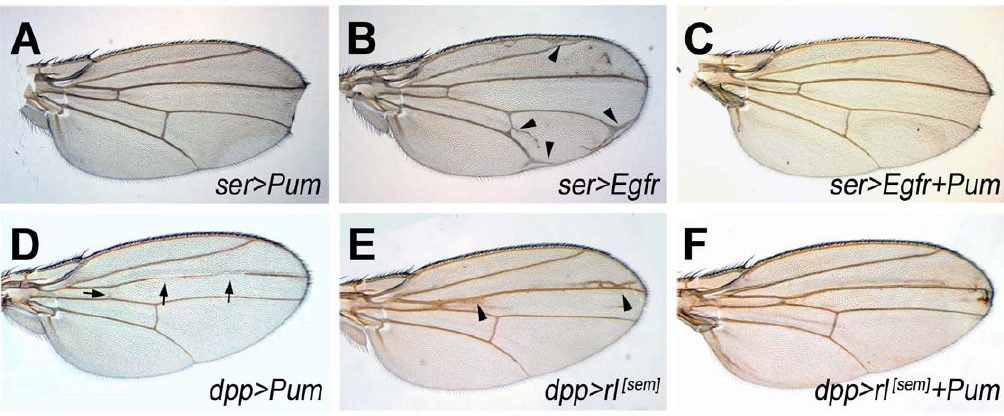
Figure 2. Pum overrides EGFR signaling. ser-Gal4 derived expression of Pum and EGFR (A-C). Pum expression ( UAS-Pum / + ; ser-GAL4 / + ) resulted in notching in the wing boundary (A). EGFR expression ( ser-GAL4 / UAS-EGFR) caused extra-wing veins (arrowhead, B). Concomitant pum expression ( UAS-Pum / + ; ser-GAL4 / UAS-EGFR ) diminished extra wing veins induced by enhanced EGFR signaling and generated notch around wing boundary (C). dpp-Gal4 derived expression of Pum and rl [Sem] (D-F). Pum expression ( UAS-Pum / + ; dpp-GAL4 / + ) eliminated wing veins (arrow, D), whereas rl [Sem] expression ( dpp-GAL4 .. UAS-rl [Sem] ) produced extra wing veins (arrowheads in E) at the A/P boundary. Concomitant Pum expression diminished extra wing veins induced by enhanced Rl signaling ( UAS-Pum / UAS- rl [Sem] ; dpp-GAL4 / + ) (F).